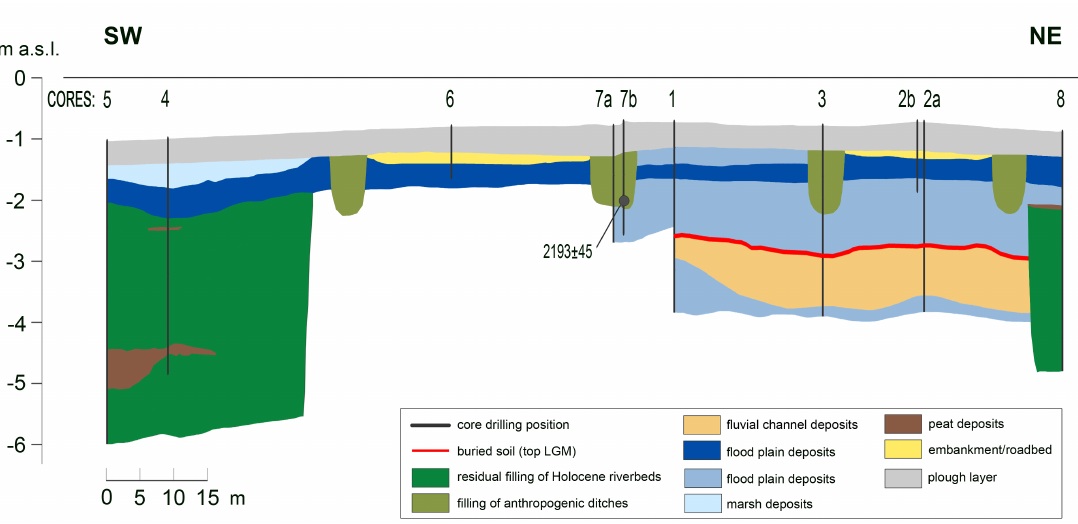
Figure 8. Section across the study site. Table 3. Details of the 14 C dating of a wood sample from the core 7b (see Figure